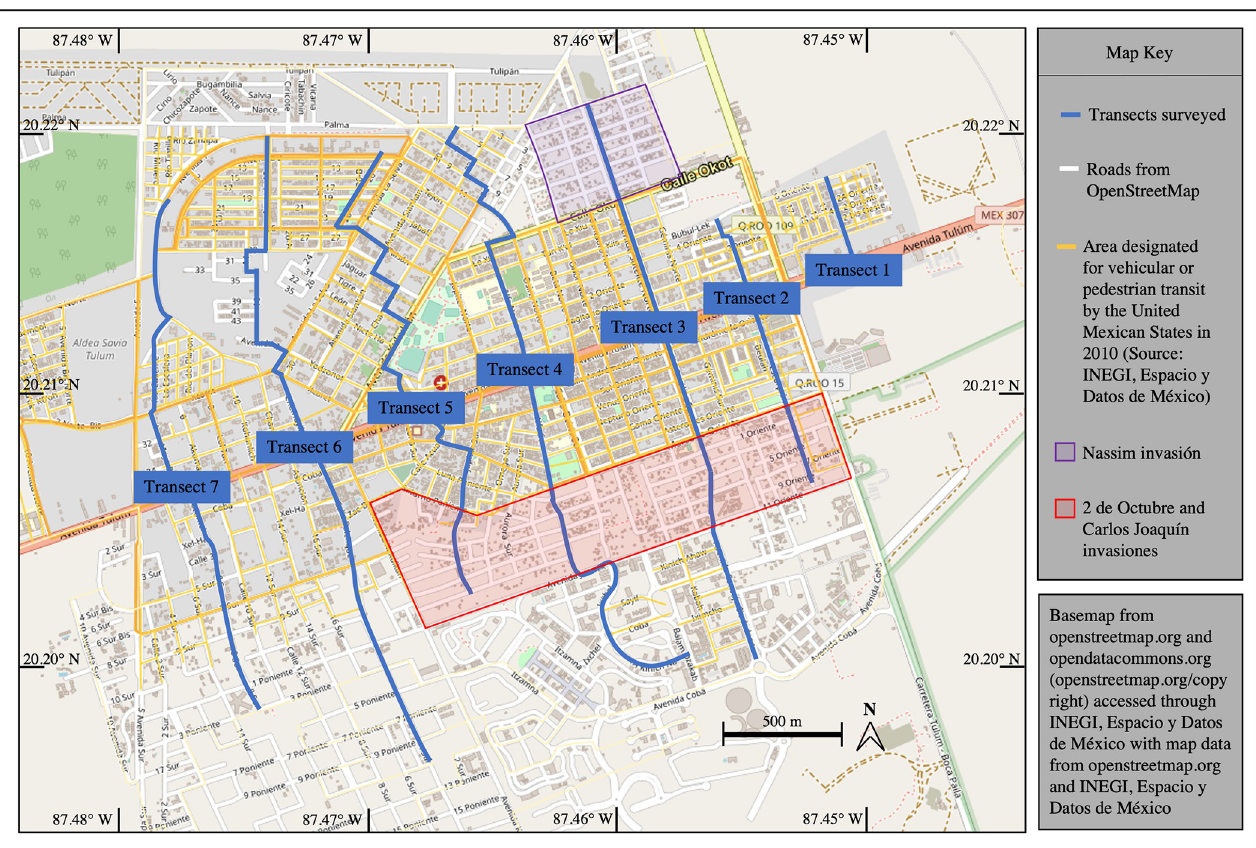
Fig 1. Map of transects sampled in Tulu´m, Quintana Roo, Me´xico. Transects were used to determine the population status of free-roaming dogs within the city limits.